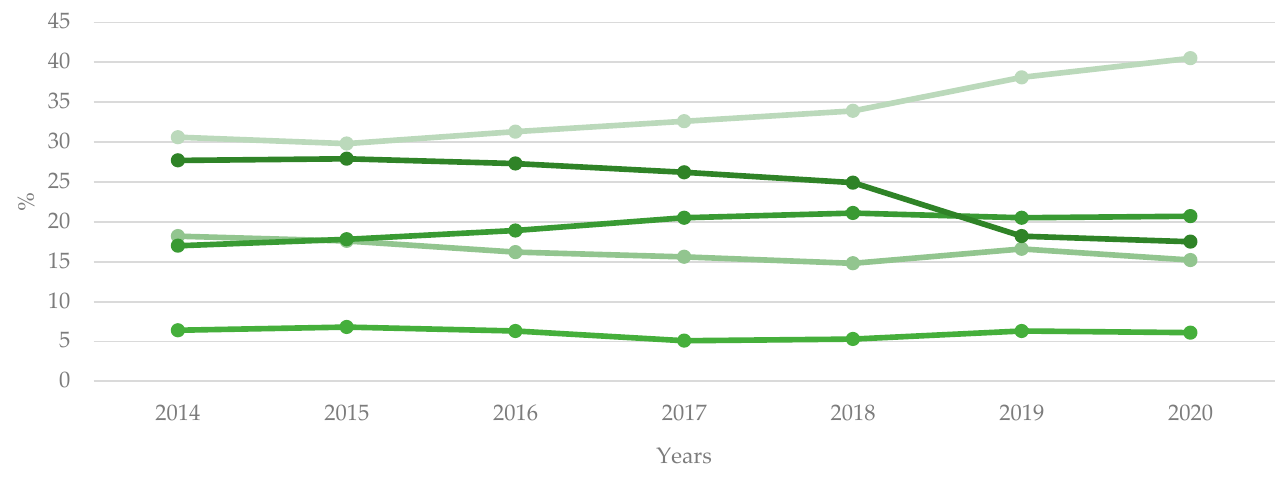
Figure 2. Sources of income of the rural population in the Republic of Moldova [49].